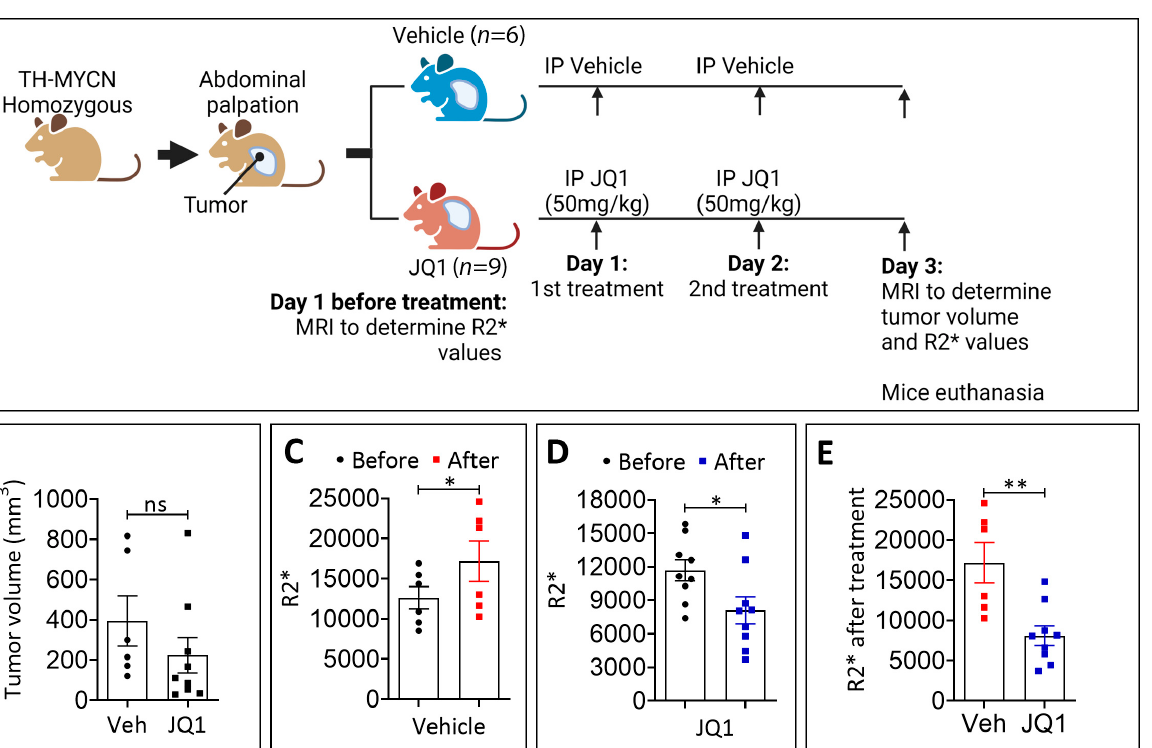
Figure 2. Effect of JQ1 on the hypoxia status and blood vessels in TH-MYCN tumor-bear- ing mice. ( A ) Experimental design of JQ1 treatment of TH-MYCN tumor-bearing mice showing the schedule and dosing. Following the development of homozygote TH-MYCN